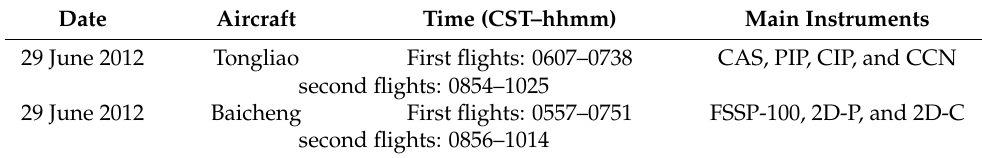
Table 1. Flight features including aircraft, beginning and end times, and main instruments.